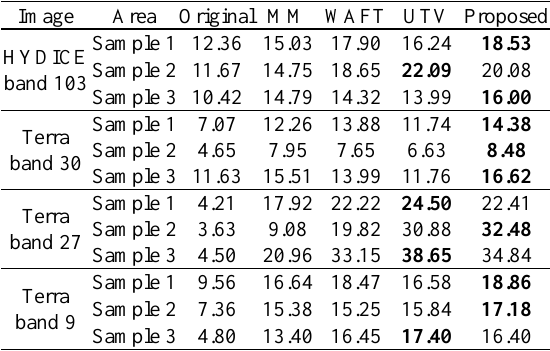
Table 1. Quantitative evaluation results using ICV